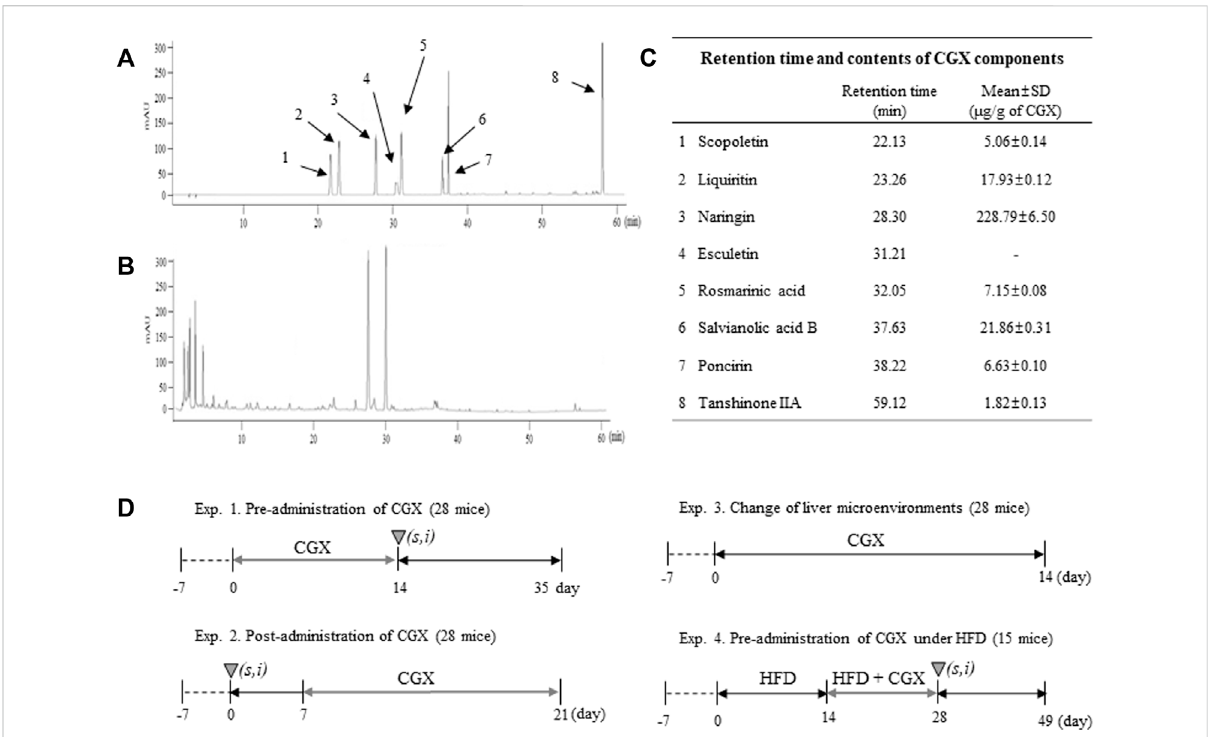
FIGURE 1 Fingerprinting of CGX and animal experimental designs. Eight reference compounds (A) in CGX (B) were analyzed using HPLC, and semiquantitative analysis was performed using their standard curves (C) . The mice (99 mice in total) were used according to four different experimental designs (D)